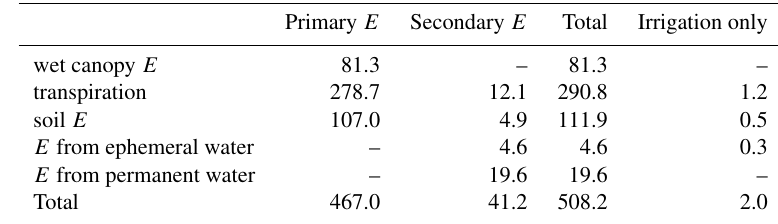
Table 3. Estimates of annual primary and secondary evaporation ( E in mmyr − 1 ) components for 2001–2014 expressed as water depths across the global terrestrial area (149 × 10 6 km 2 ) .